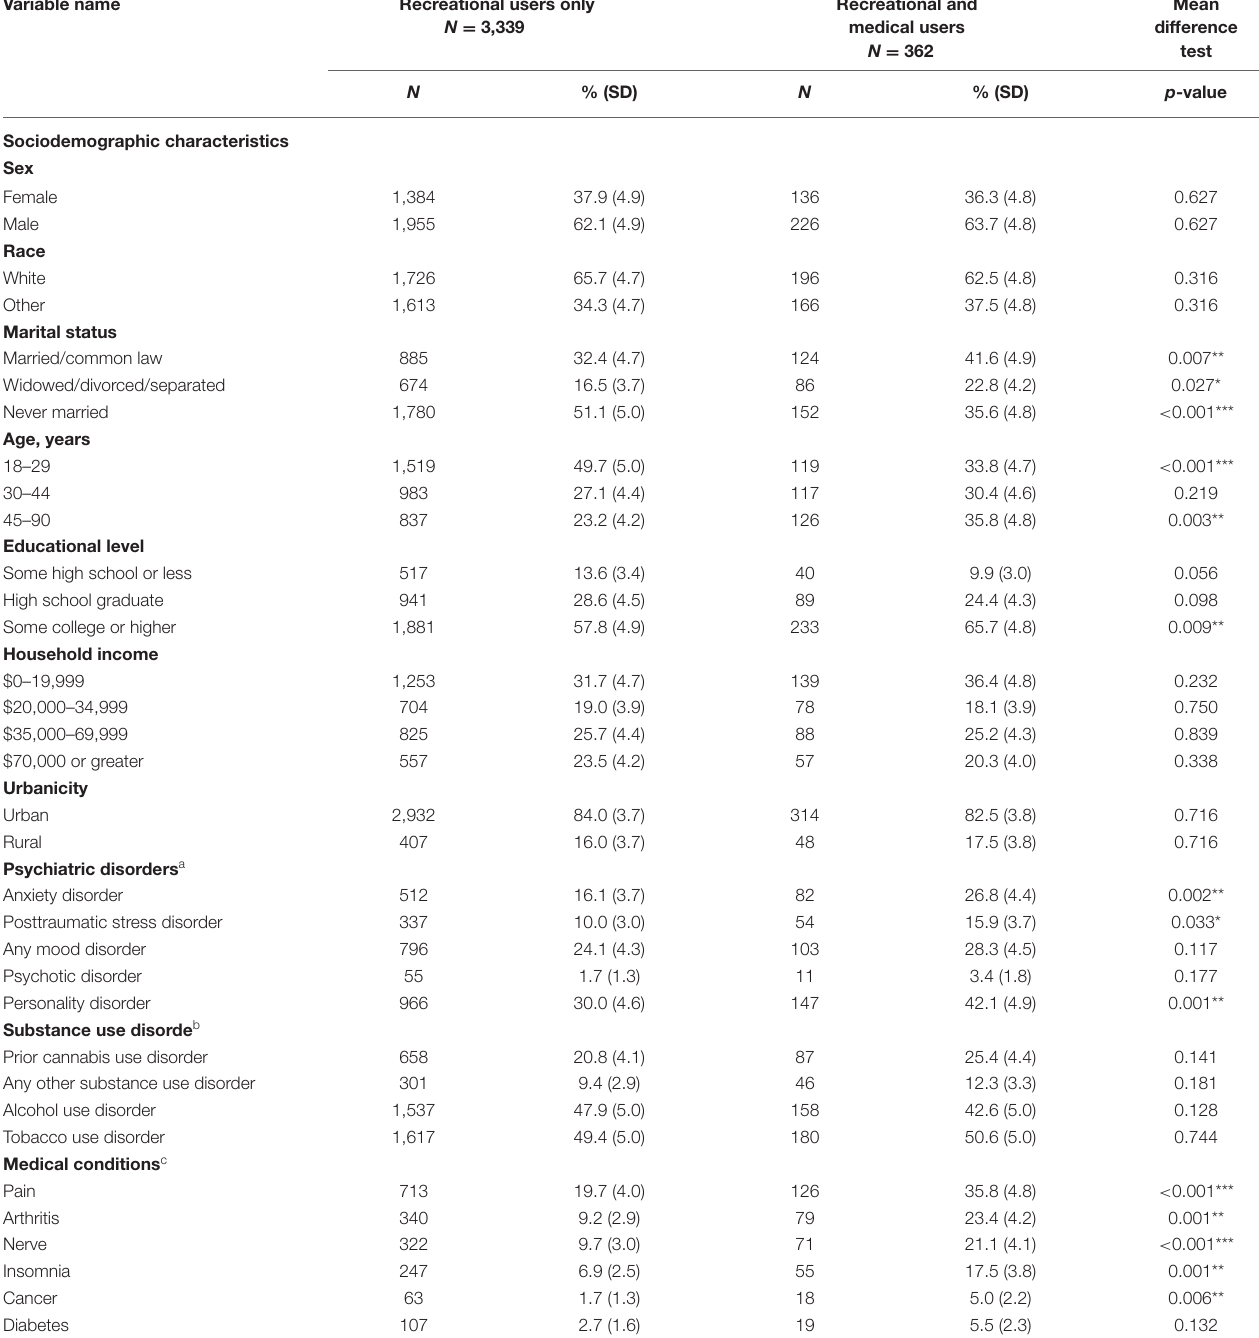
TABLE 1 | Characteristics of 12-month cannabis users in two population